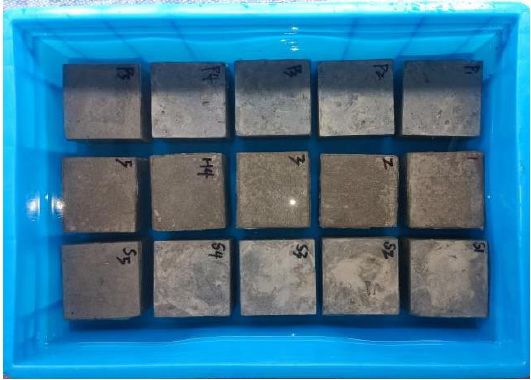
Figure 4. Specimens being soaked.